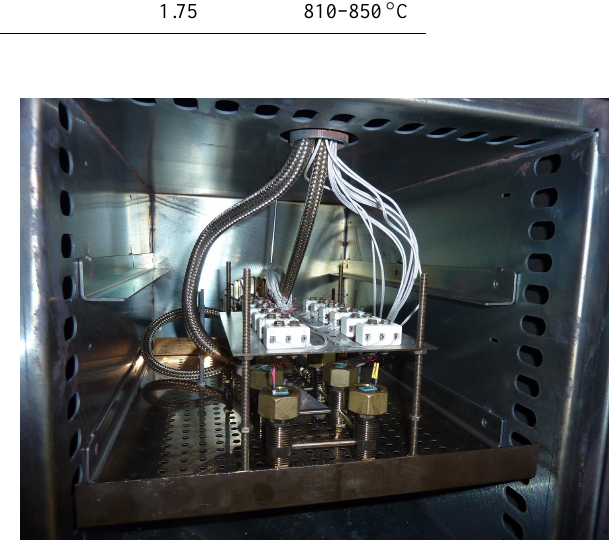
Figure 3. High temperature pressure measurement station for char- acterizing sensors up to 200 bar and 650 ◦